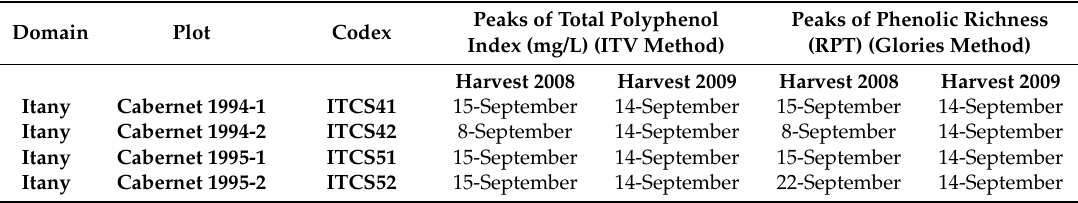
Table 1. Dates of peaks of the total polyphenol index and phenolic richness for each plot of Cabernet Sauvignon respectively detected by the ITV and Glories methods (1 and 2) for 2008 and 2009 harvests.